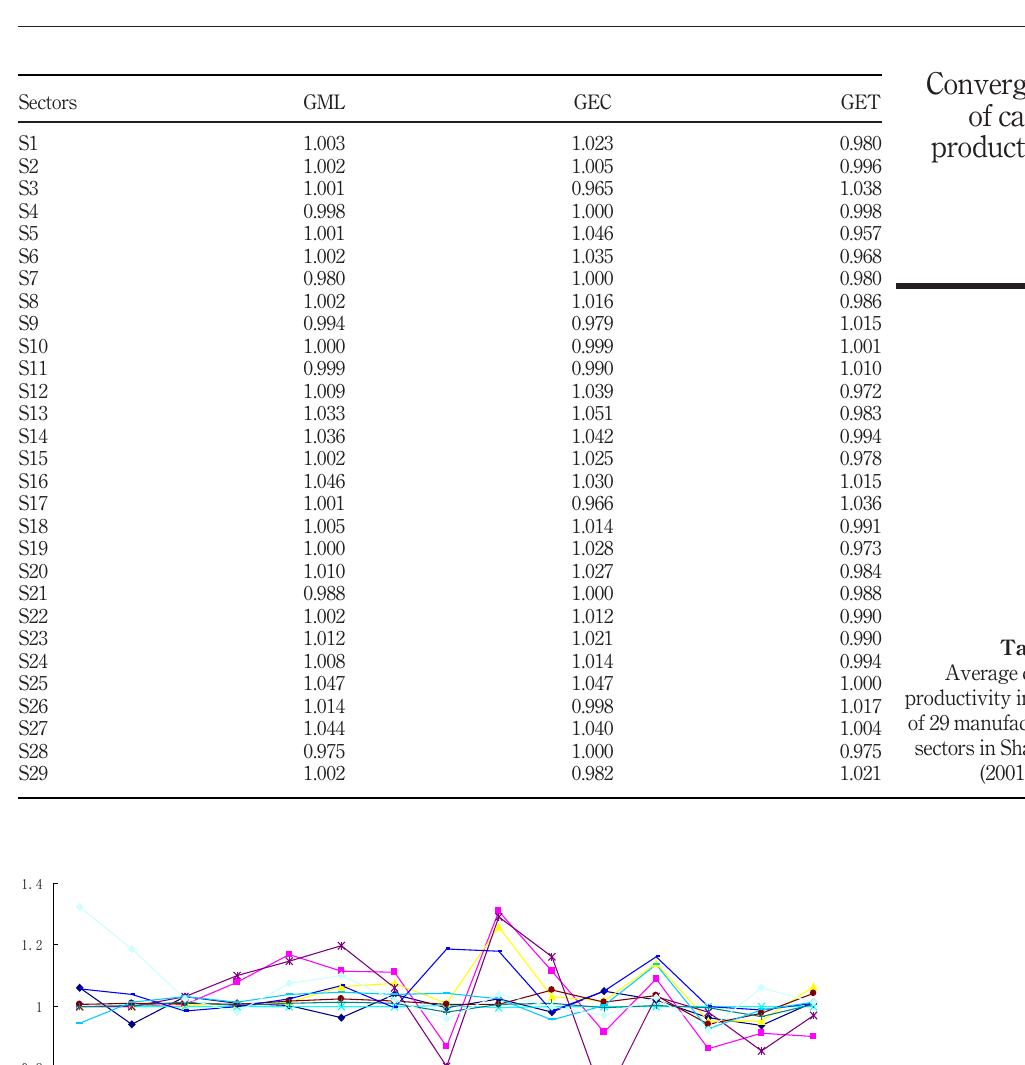
Figure 2. Trends of